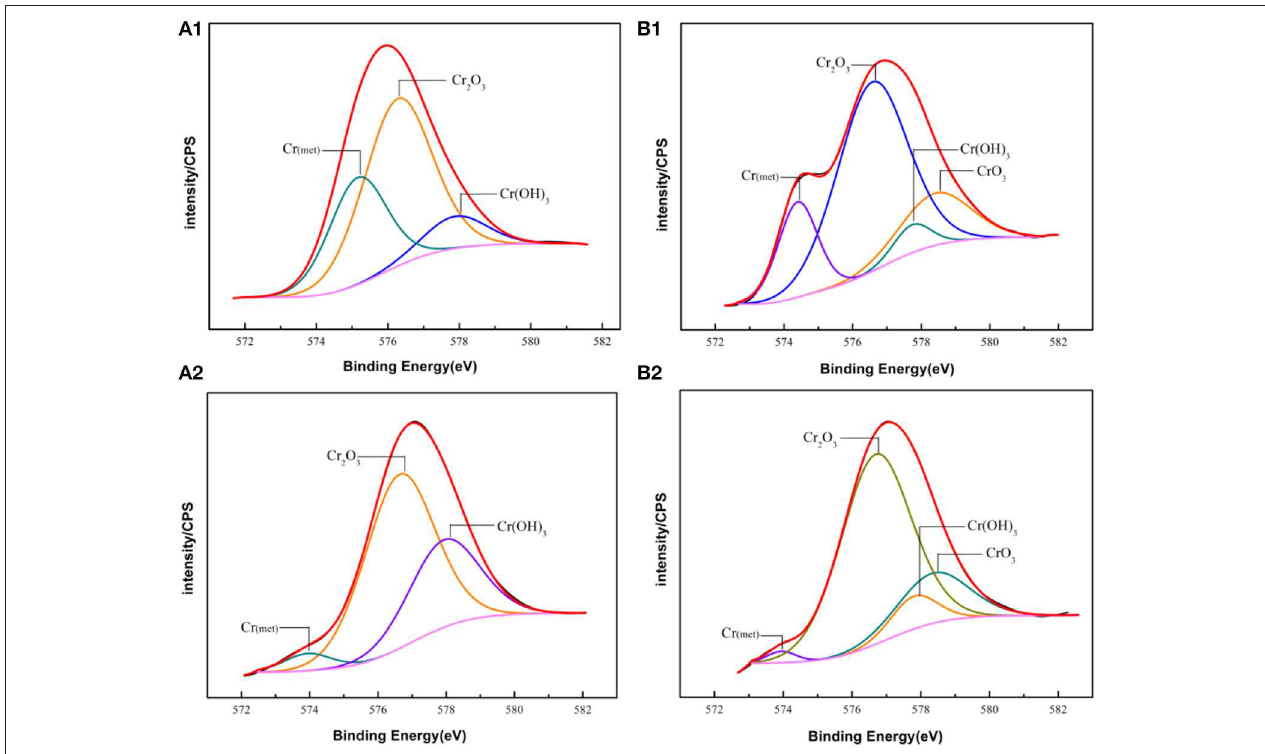
FIGURE 8 | Experimental and fitted narrow XPS spectra of Cr 2p of the surface film of (A1,B1) Bare and pre-passivated sample before exposure; (A2,B2) Bare and pre-passivated sample after 5 year exposure.